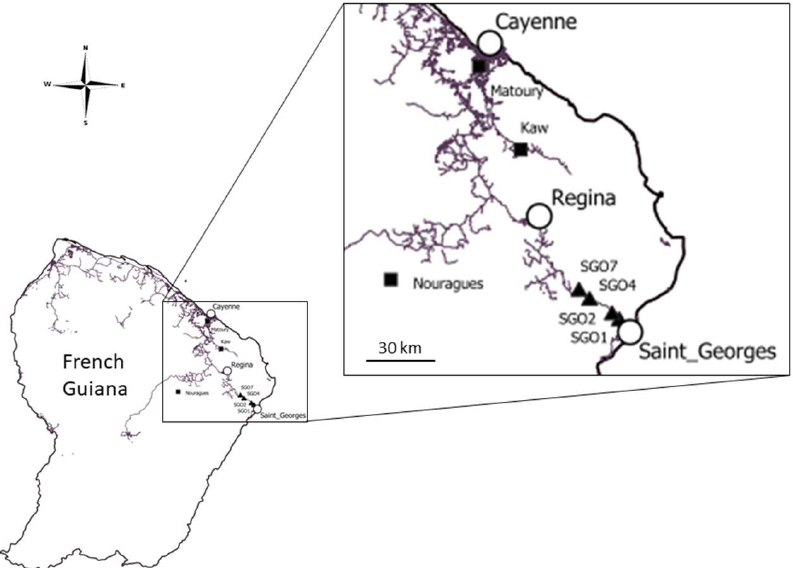
Figure 1. Sampling locations. Dung beetles have been sampled at SGO1, SGO2, SGO4 and SGO7, located at a distance of 7.8, 11.8, 25.6 and 32 km from Saint-Georges-de-l’Oyapock, respectively. Black triangles represent the original sample of this study and black squares represent sample sites of the study of Feer & Boissier [8]. White circles are the main cities along the RN2 road. Lines represent roads.